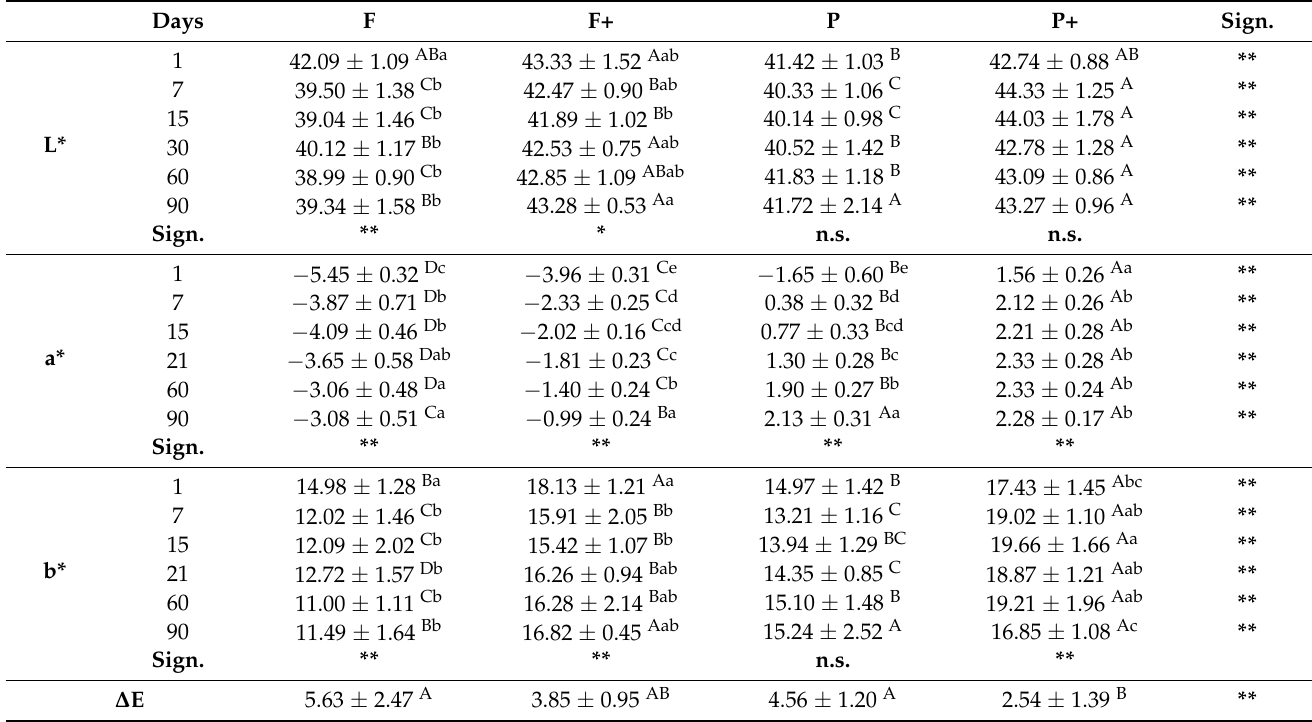
Table 3. Color parameters of pesto samples during storage time.